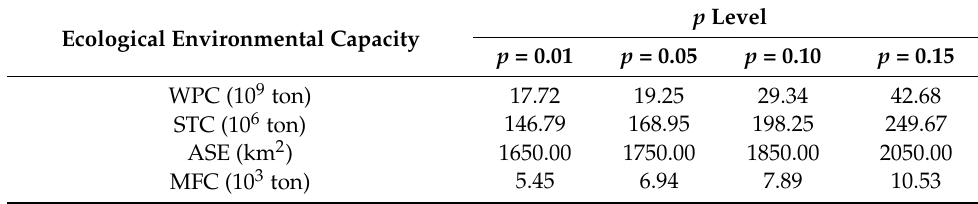
Table A5. Ecological/environmental parameters under different p